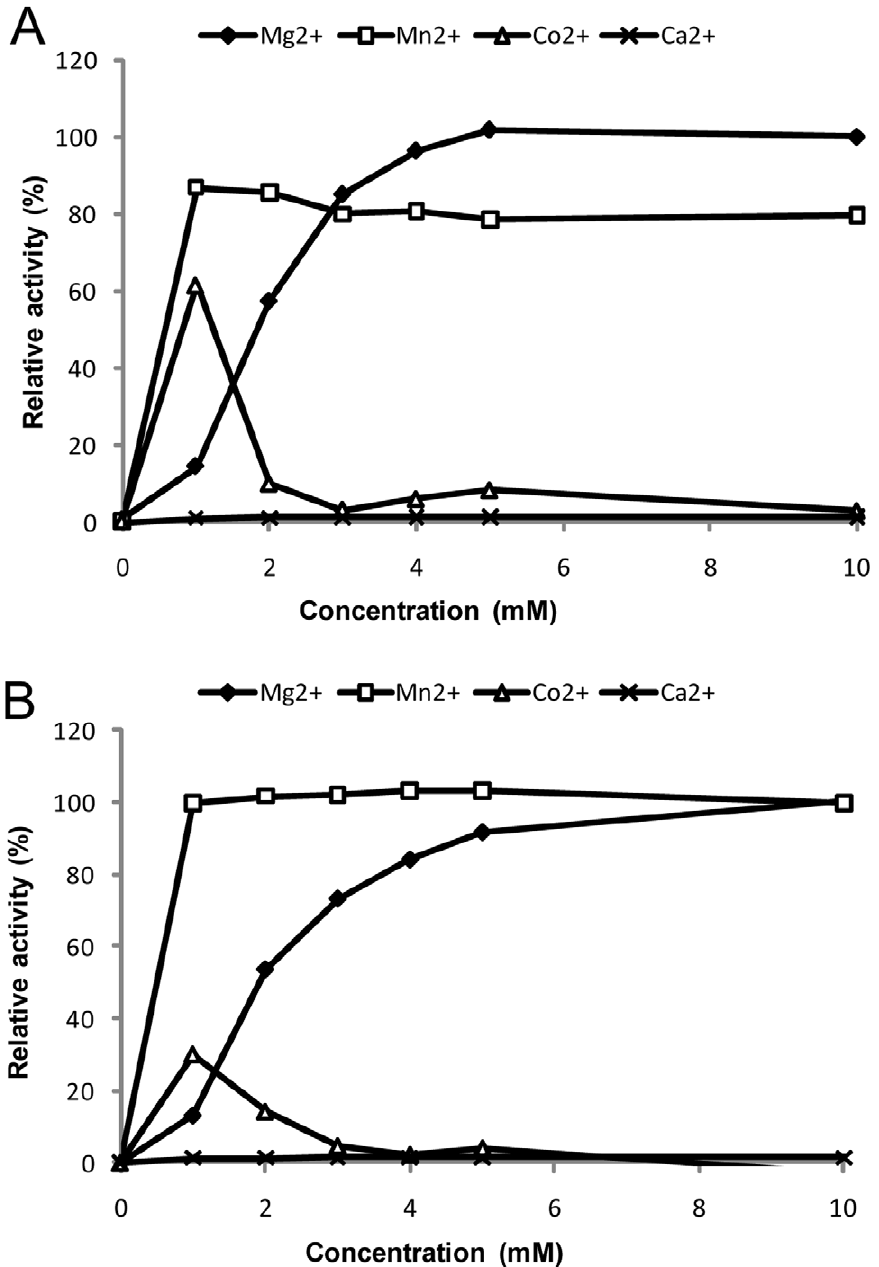
Figure 3. Influence of divalent cations on enzyme activity. Relative activity of native (A) and recombinant (B) shrimp nuclease in presence of various divalent cations. Enzyme activity was measured using the modified Kunitz assay, and one hundred percent activity was set at 10 mM MgCl 2 .